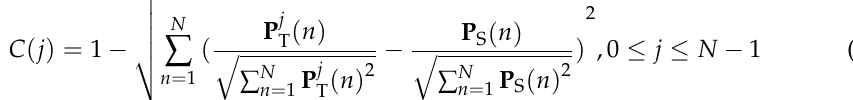
Figure 3. Illustration of color codes ( N = 12). The color codes’ features of the image pair are extracted and marked as P T , P S , respectively. The normalized Euclidean distance of the color codes feature is used to represent the correlation of the image pair, as shown in Equation (8).